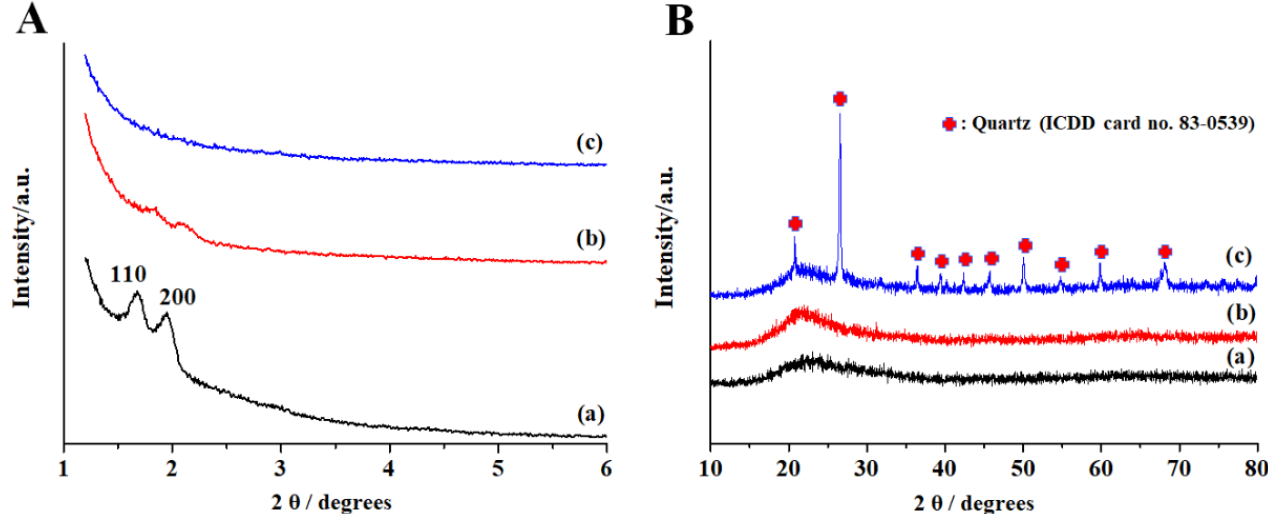
Figure 8. XRD patterns in the range of low angle (2θ = 1.2 – 6°) ( A ) and wide angle (10 – 80°) ( B ) of (a) SBA15-Li-40-700, (b) SBA15-K-40-700 and (c) SBA15-Ca-40-700 after thermal treatment at 700 °C using different metal ions (Li + , K + and Ca 2+ ) with Si/metal ion = 40.